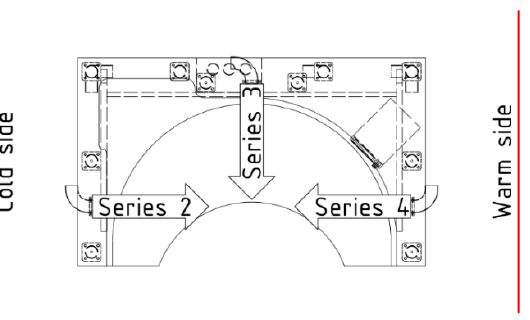
Table 3. Average face temperature Figure 8. Histogram of the surface temperatures from the face.